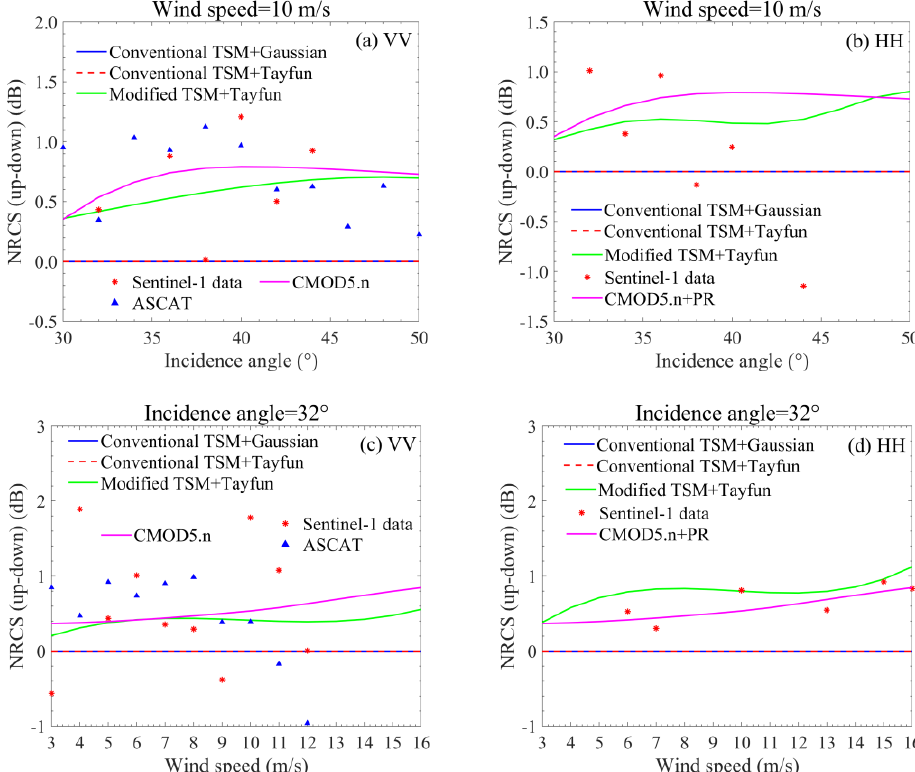
Figure 11. The upwind-downwind asymmetries predicted based on conventional TSM + Gaussian sea surface, conventional TSM + Tayfun sea surface, and modified TSM + Tayfun sea surface and their comparison with the reference data ( a , b ) as functions of the incidence angle at the wind speed of 10 m/s under VV and HH polarizations and ( c , d ) as functions of the wind speed at the incidence angle of 32° under VV and HH polarization. Curves and symbols are the same as those in Figure 8.